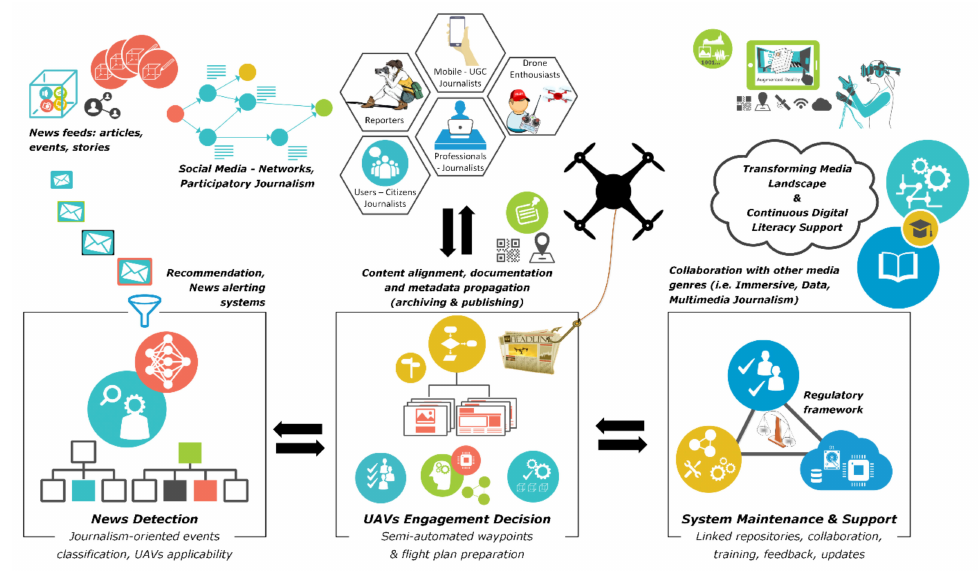
Figure 1. The envisioned concept architecture of the proposed model [8].